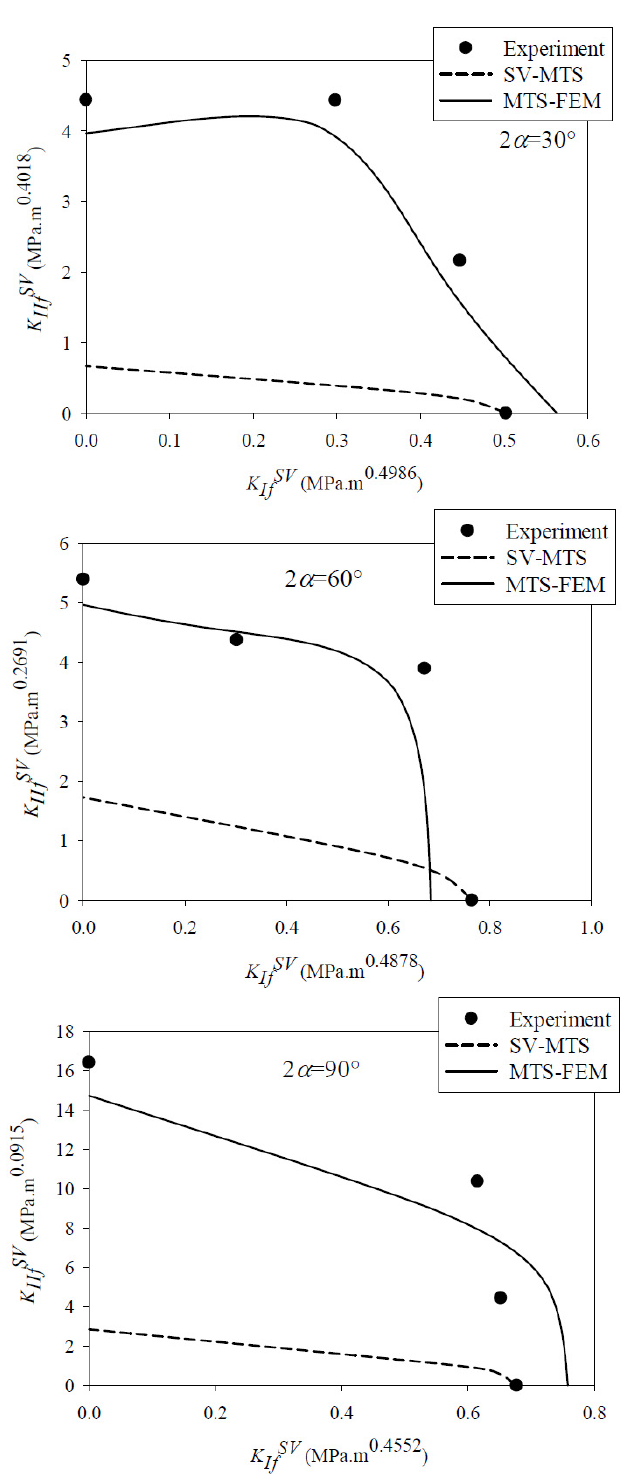
Figure 8. Comparison between the fracture curves of the SVNBD samples predicted by the SV-MTS and the MTS-FEM criteria and the experimental results. Notch opening angles of 2 α = 30°, 2 α = 60° and 2 α = 90°.